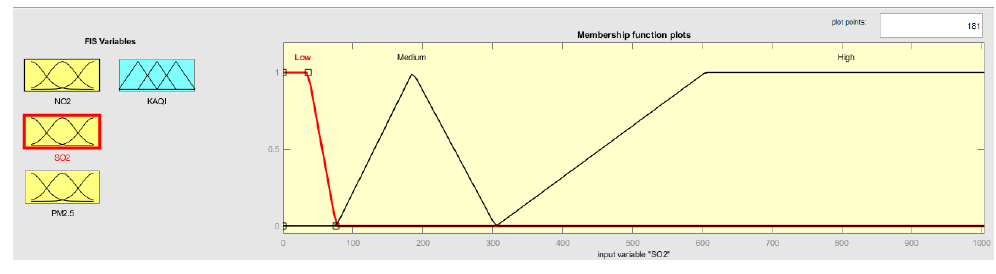
Figure 5. SO 2 input variable.